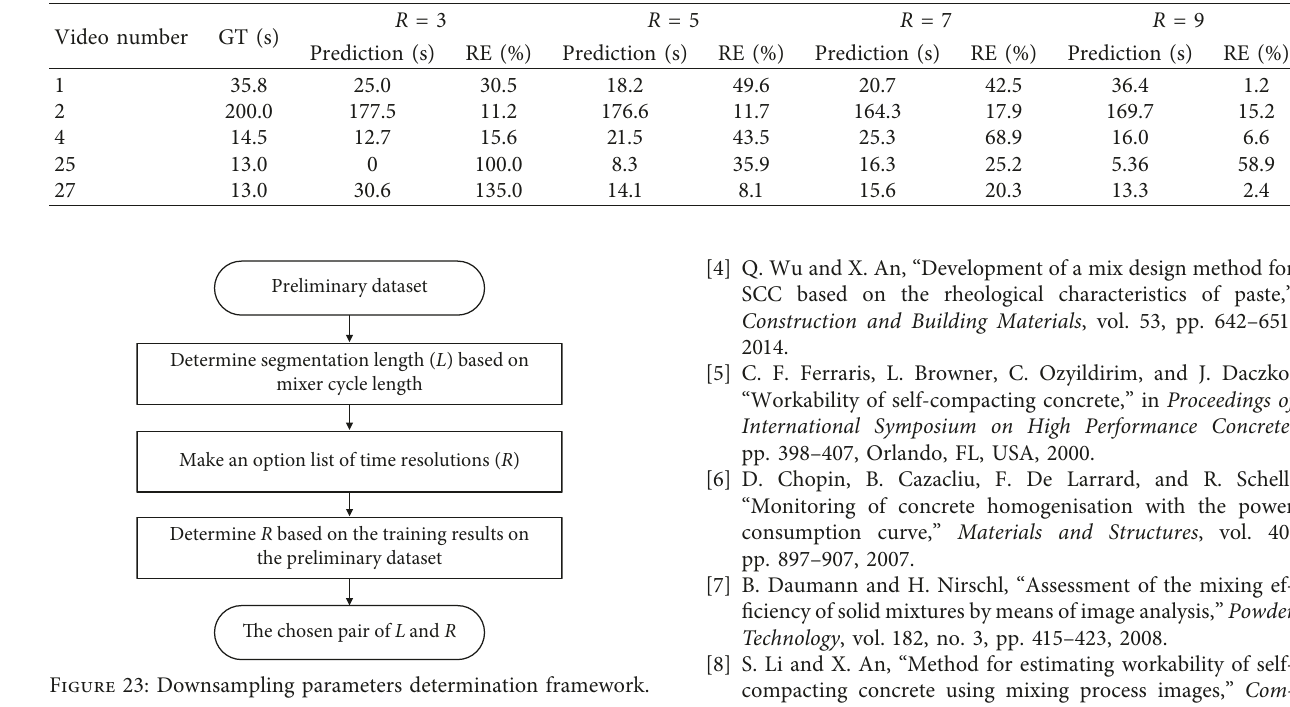
Table 7: Prediction results of VF values with different R .